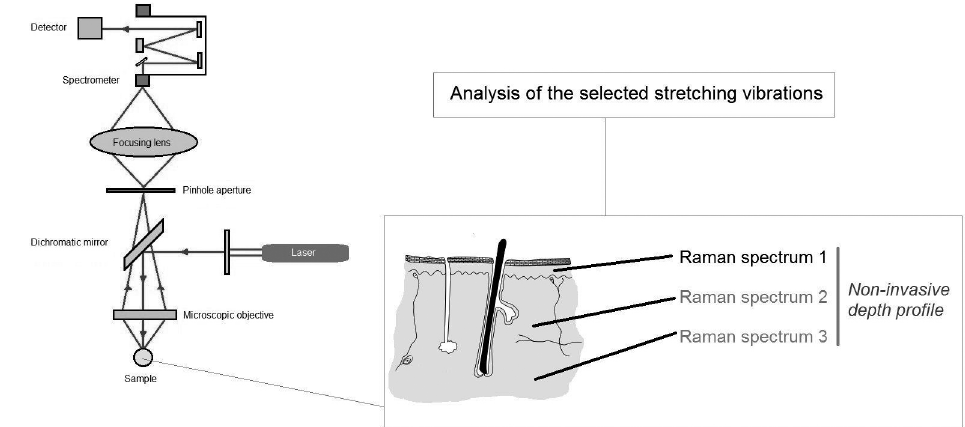
FIGURE 4 - Analysis using Raman confocal